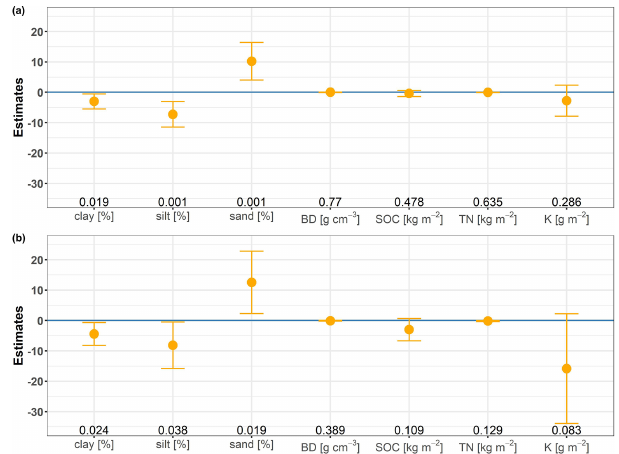
Figure 6. (a) Estimates and 95% confidence intervals of linear re- gression models, comparing entire soil profiles under disturbed for- est showing no regrowth of trees (DNOR; orange) to those under disturbed forest with regrowth of trees (DWIR; blue; n = 305). P values indicated below the plots were calculated for the differences between the estimates for soils under DNOR and DWIR. Data for exchangeable Mg were left out for better readability (estimate is + 4.5; confidence intervals are + 21 . 2 / − 12 . 2; p = 0 . 596). (b) Es- timates and 95% confidence intervals of linear regression models, comparing the uppermost 10cm of the soil profiles under DNOR (orange) to those under DWIR (blue; n = 54). P values indicated below the plots were calculated for the differences between the esti- mates for soils under DNOR and DWIR. Data for exchangeable Mg were left out for better readability (estimate is − 32.2; confidence intervals are + 16 . 5 / − 80 . 9; p = 0 . 184). BD is bulk density, SOC is soil organic carbon, TN is total nitrogen, and K is exchangeable